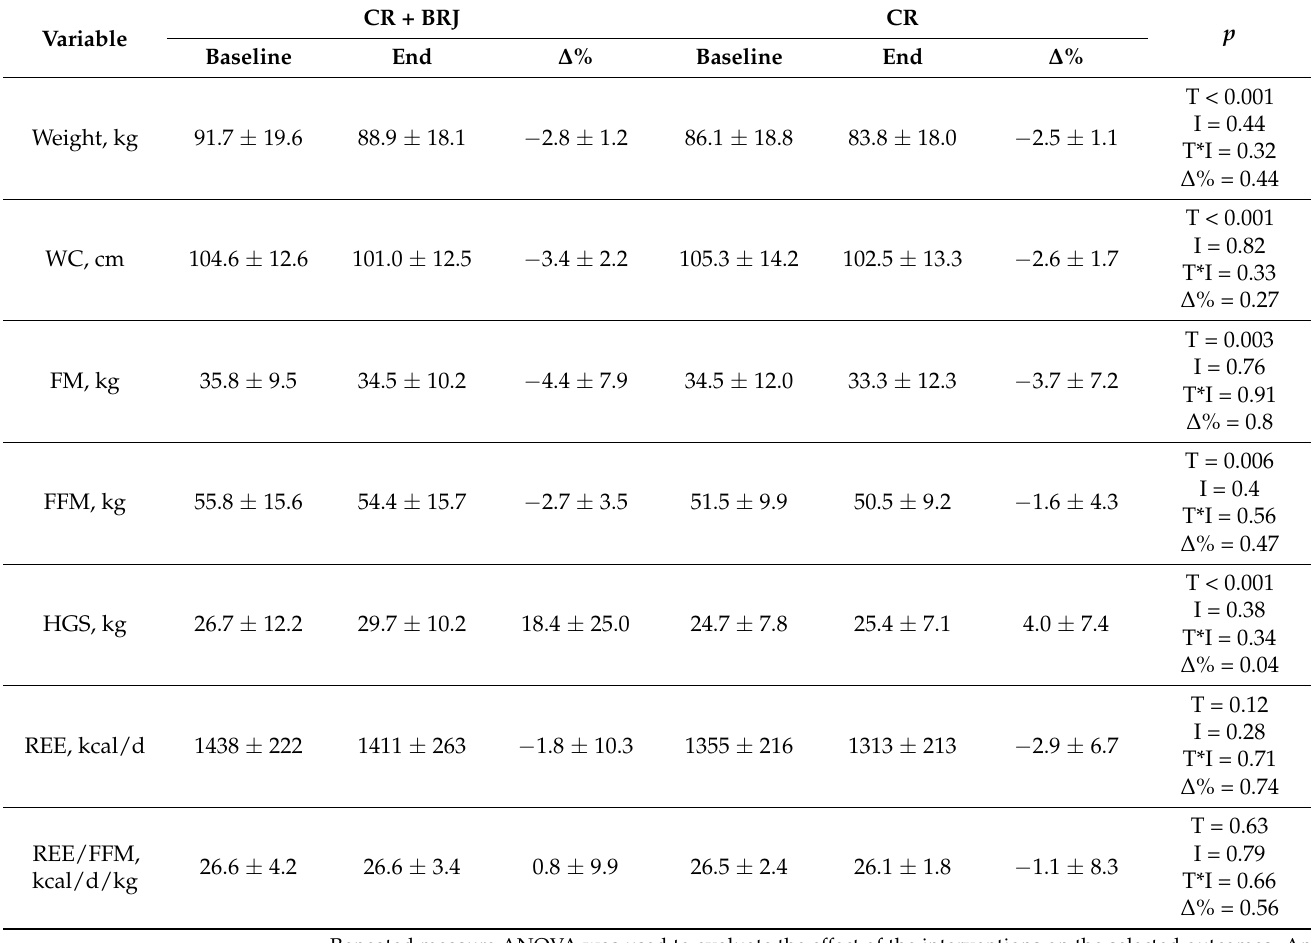
Table 2. Anthropometry, body composition, hand-grip strength, and resting energy